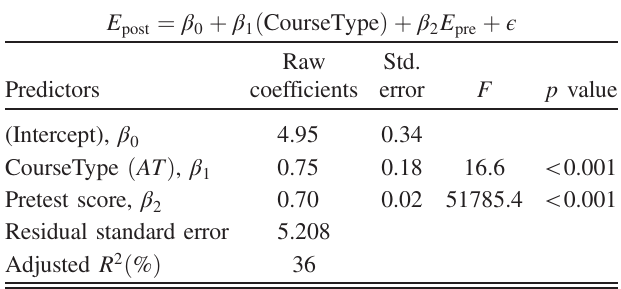
TABLE IV. Results of linear regression (ANCOVA) for the class ’ s overall post-test scores while controlling for pretest scores.